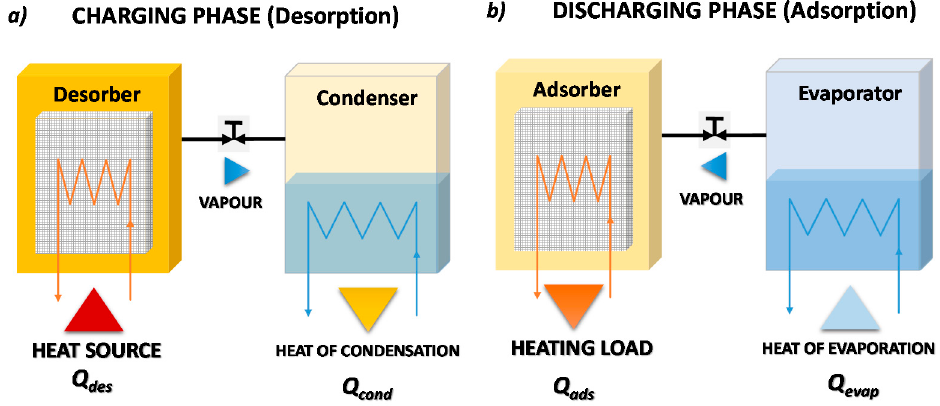
Figure 5. A closed adsorption heat storage cycle: ( a ) charging phase; ( b ) discharging phase.